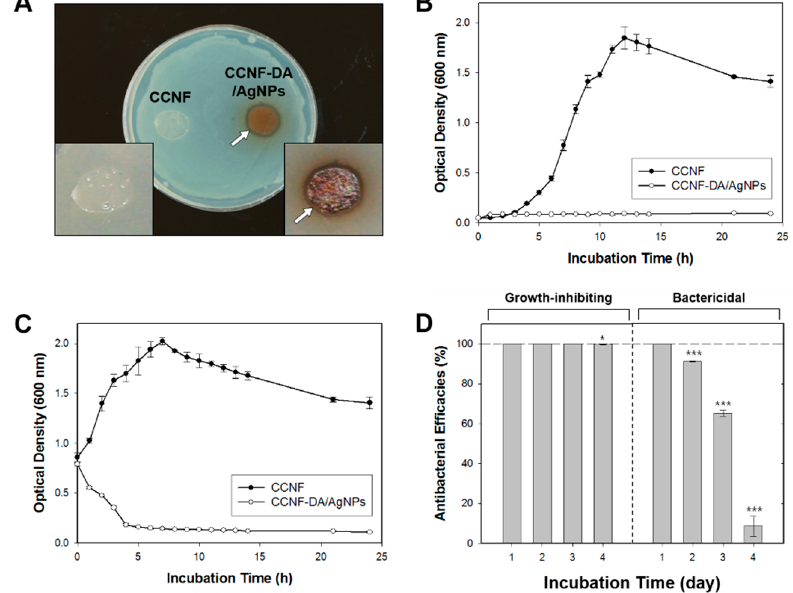
Figure 5. Antibacterial test on CCNF-DA/AgNPs membrane. ( A ) Disk diffusion test; ( B ) bacterial growth profiles; and ( C ) bactericidal profiles of the CCNF-DA/AgNPs membrane against E. coli ; ( D ) Growth-inhibiting ( left ) and bactericidal ( right ) efficacies of CCNF-DA/AgNPs membrane for a long period. White arrows indicate the inhibition zone. The data represent mean ± standard deviation with statistical significance ( * p < 0.05, ** p < 0.01, *** p < 0.005; unpaired t -test).